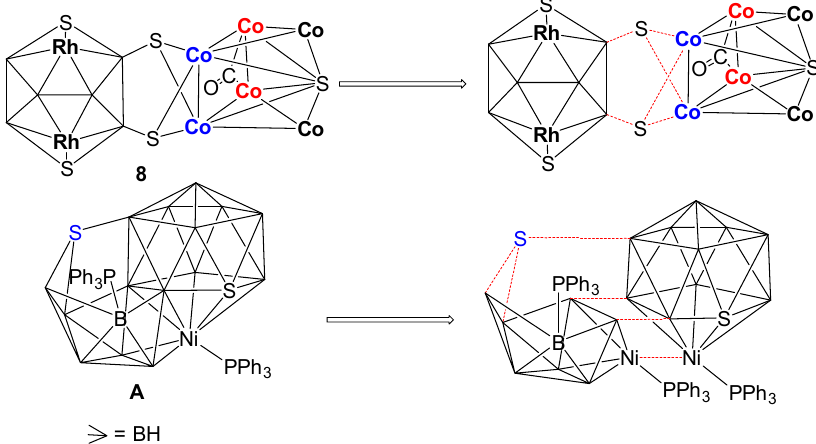
Figure 7. Representation of intercluster crosslink in clusters 8 and [(PPh 3 )NiS 2 B 16 H 12 (PPh 3 )].